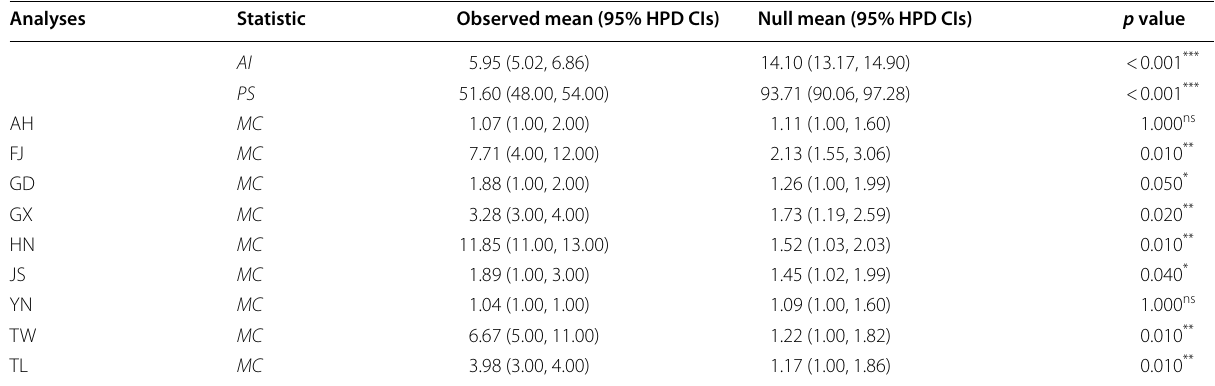
Table 3 Phylogeny–trait association test for phylogeographic structure of